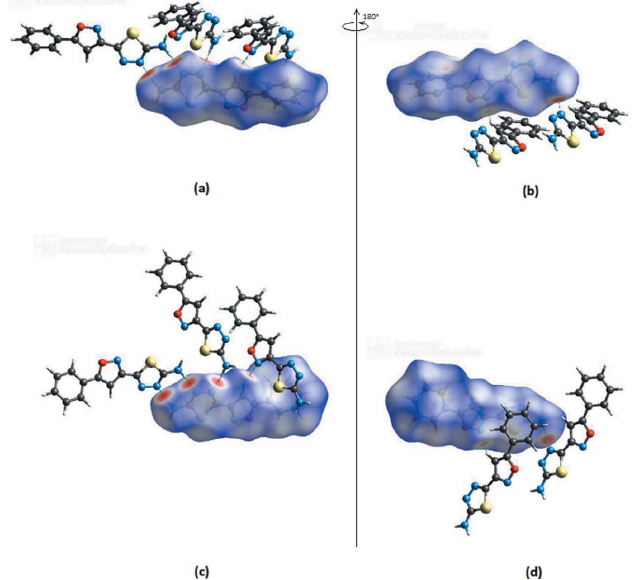
Figure 6 Front ( a ) and back ( b ) views of the three-dimensional Hirshfeld surface for molecule I. Front ( c ) and back ( d ) views of the three-dimensional Hirshfeld surface for molecule II. Some intermolecular N—H (cid:2)(cid:2)(cid:2) N and C—H (cid:2)(cid:2)(cid:2) N interactions are shown as dashed lines. combination of C—H (cid:2) (cid:2) (cid:2) O hydrogen bonds forms stepped